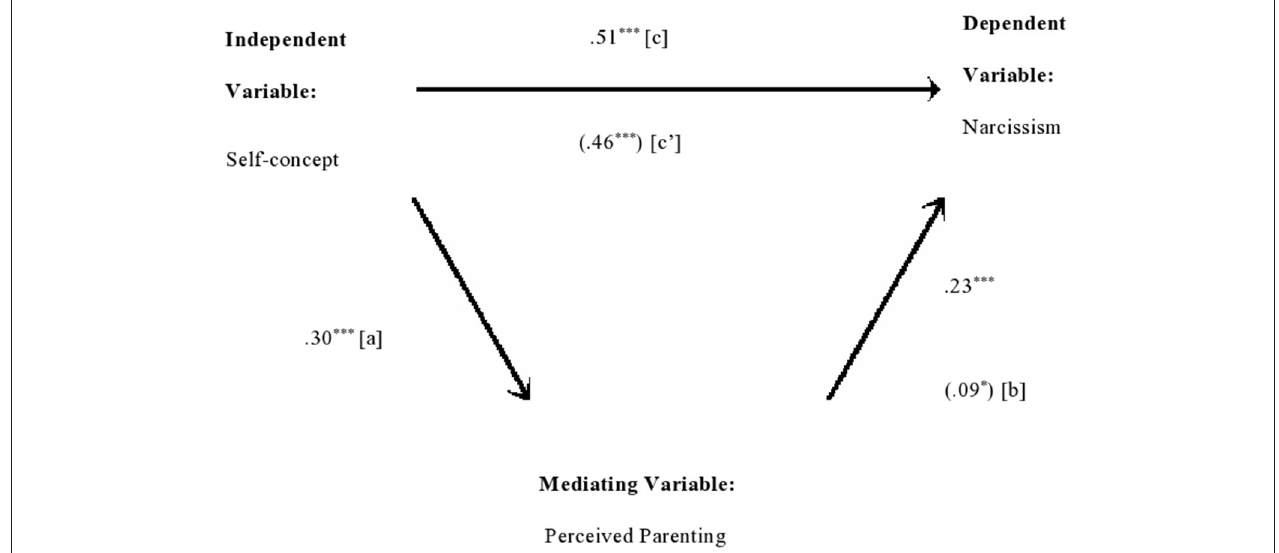
FIGURE 1 | Medgraph shows indirect effect of self-concept and narcissism through perceived parenting. The numerical values in parentheses are beta weights taken from the second regression and the other values are zero order correlations. *** p < 0.001 and * p < 0.05.